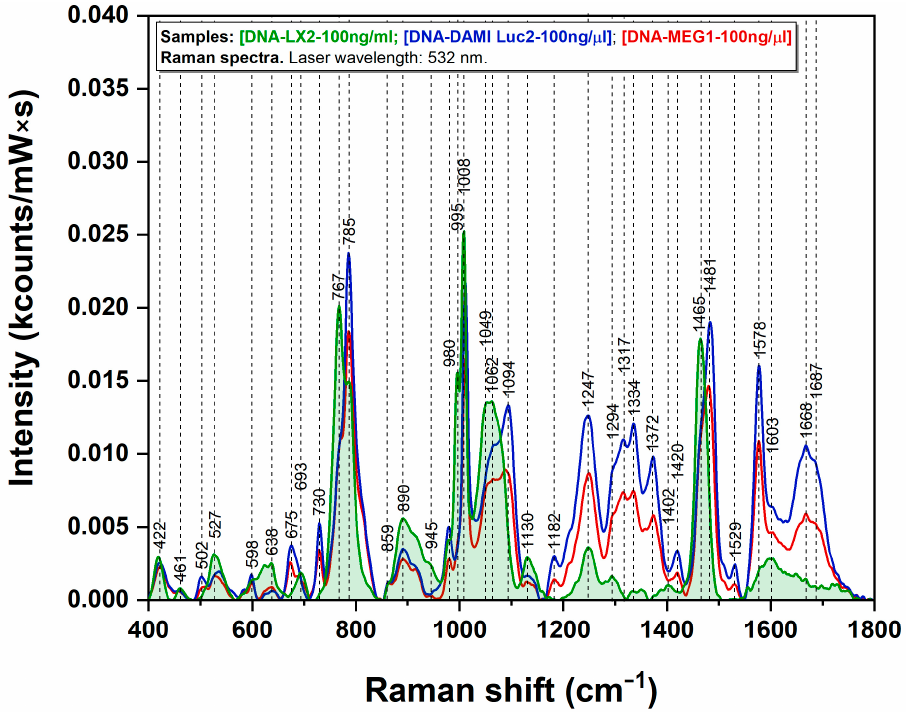
Figure 2. Raman spectra of DNA samples from leukemia cell lines DAMI Luc2 (blue), MEG-1 (red), and normal cell line LX2 (green); recorded using a 532 nm excitation wavelength.